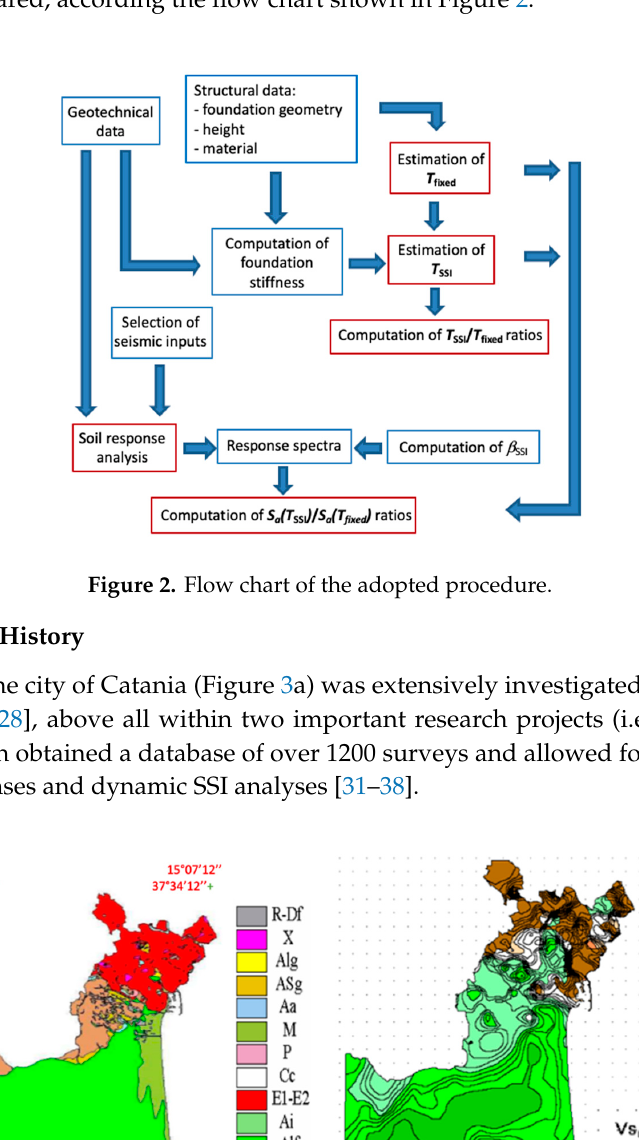
Figure 3. ( a ) Geological map of the city of Catania. ( b ) Map of average shear wave velocity (m/s) in 0– 30 m depth interval for the city of Catania (after [29]).